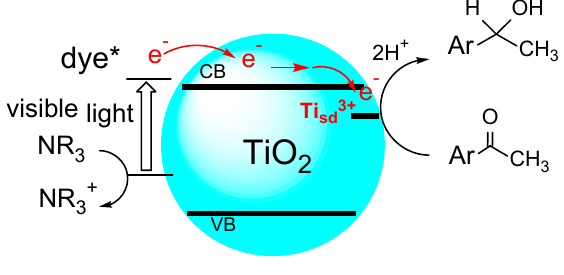
Figure 1. Photohydrogenation of acetophenone derivatives on dye-sensitized TiO 2 .